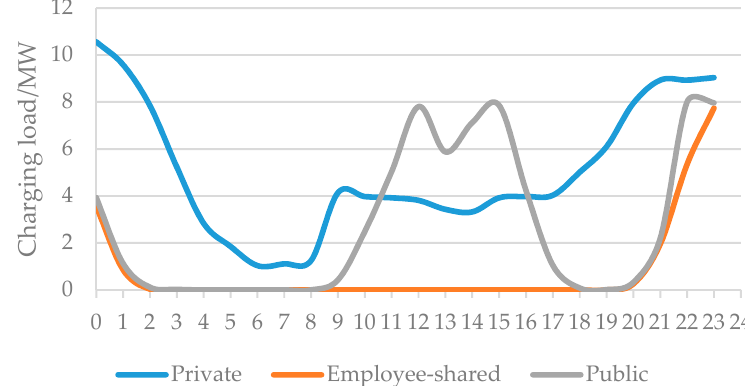
Figure 5. Charging load curves of different types of charging piles.